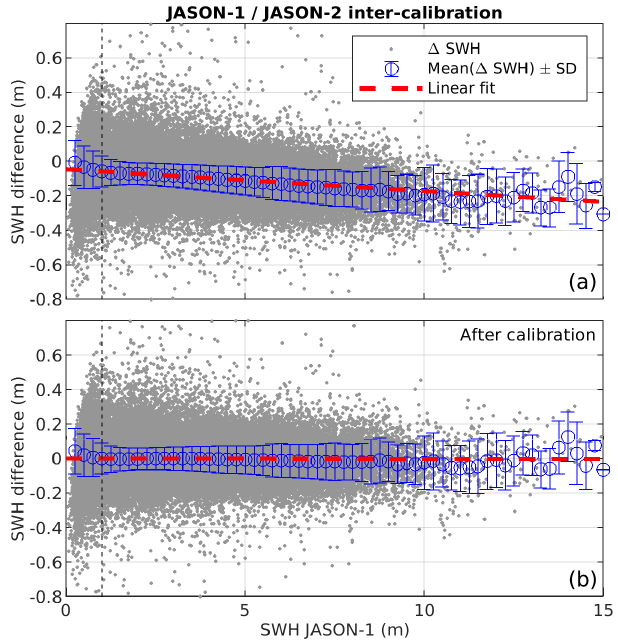
Figure 6. Residual of JASON-3 SWH − JASON-2 SWH as a func- tion of JASON-3 SWH before (top) and after (bottom) calibration. The dashed red line is a linear fit through the data.